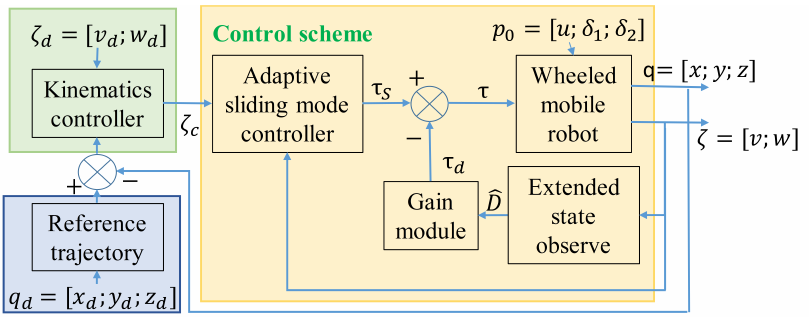
Figure 2. Block diagram of control